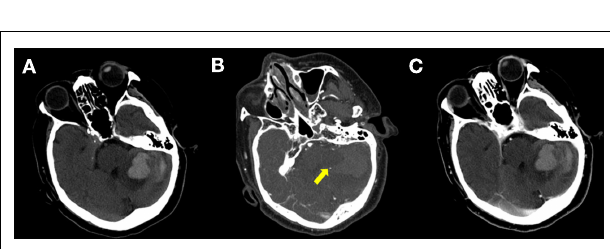
FIGURE 4 |A 63year old female patient presenting within 100min of symptom onset. (A) Axial non-contrast CT demonstrates acute hematoma in the left thalamus and intraventricular blood. (B) No Spot Sign was present on CTA source images. (C) Post-contrast leakage was demonstrated on the post-contrast CT image.